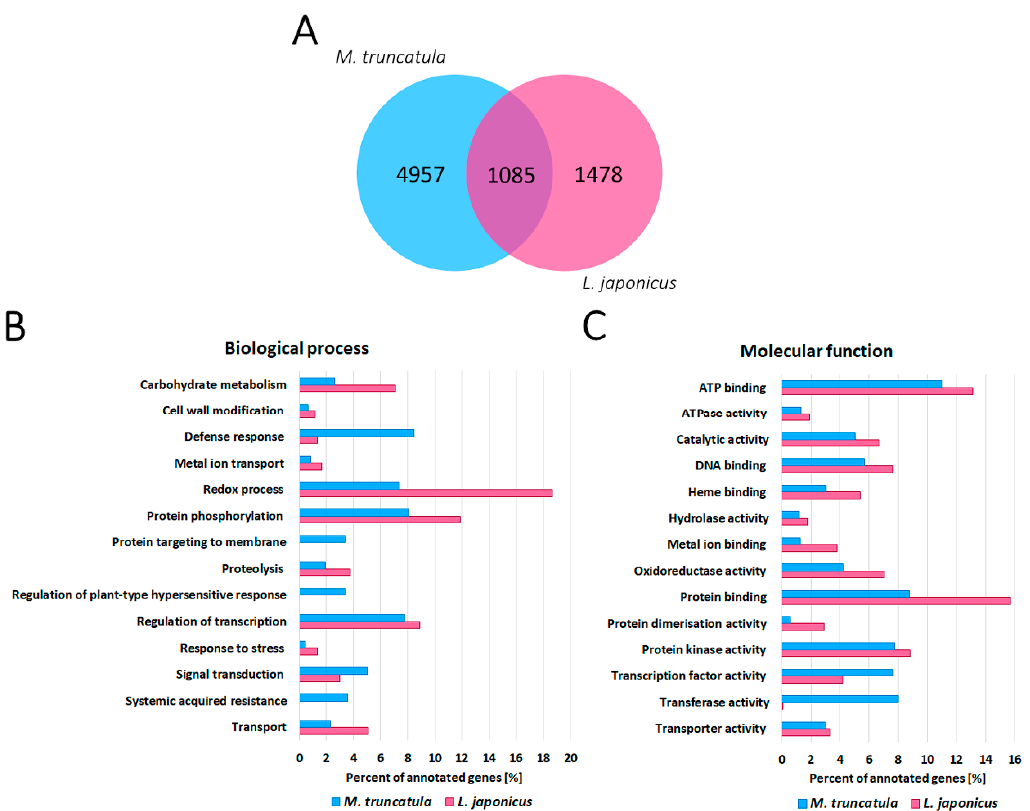
Figure 3. The number of genes differentially expressed in M. truncatula (blue) and L. japonicus (pink) root nodules, in comparison to the non-inoculated roots ( A ). The categorisation of differentially expressed genes in root nodules, in comparison to non-inoculated roots of M. truncatula (6042 genes) and L. japonicus (4830 genes), based on biological processes ( B ) and molecular functions ( C ).